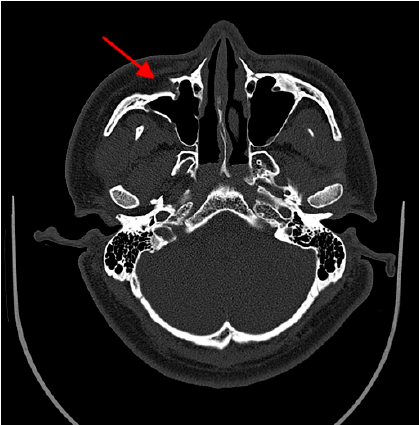
Figure 3. Imperfect reduction. Axial scan through the superior portion of the maxillary sinus and zygomatic arch. The arrow indicates the imperfect reduction of the maxillary sinus wall. Maxillary sinus pathology including mucosal thickening, gas–fluid level, and maxil- case-control analysis.